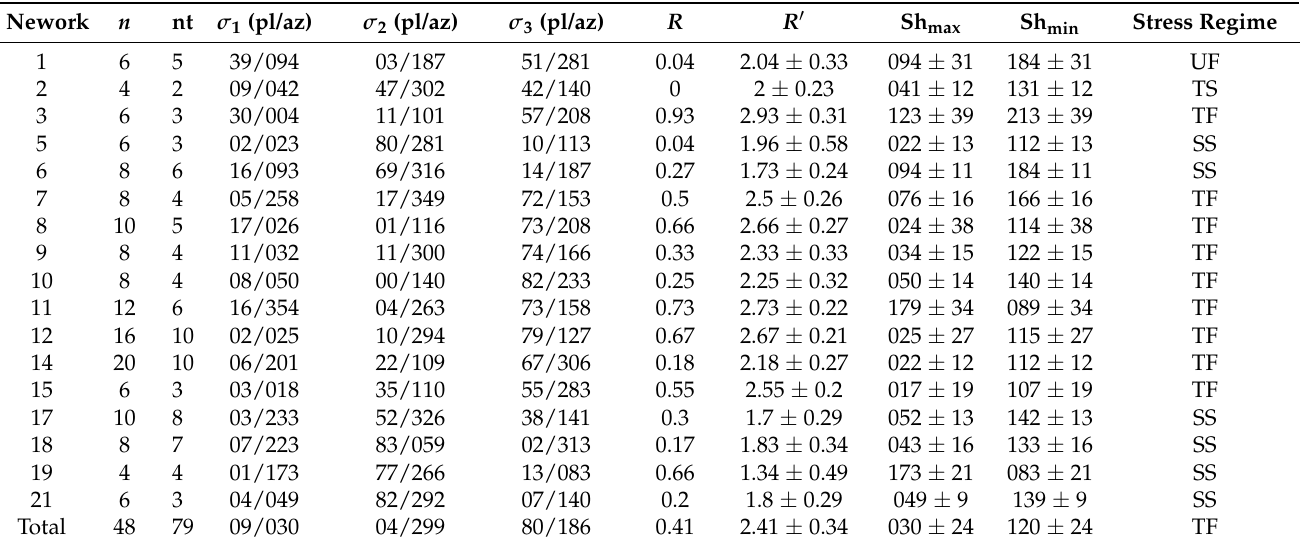
Table 3. The obtained parameters from the Rotational Optimization method for the networks (nt: the number of used data for the networks, σ 1 , σ 2 , σ 3 : the axes position of the main principal stress, R : the stress value, R (cid:48) : the stress regime index, and Sh min and Sh max are the azimuths of minimum (compressional) and maximum (extensional) axes for the seismic strain rate,